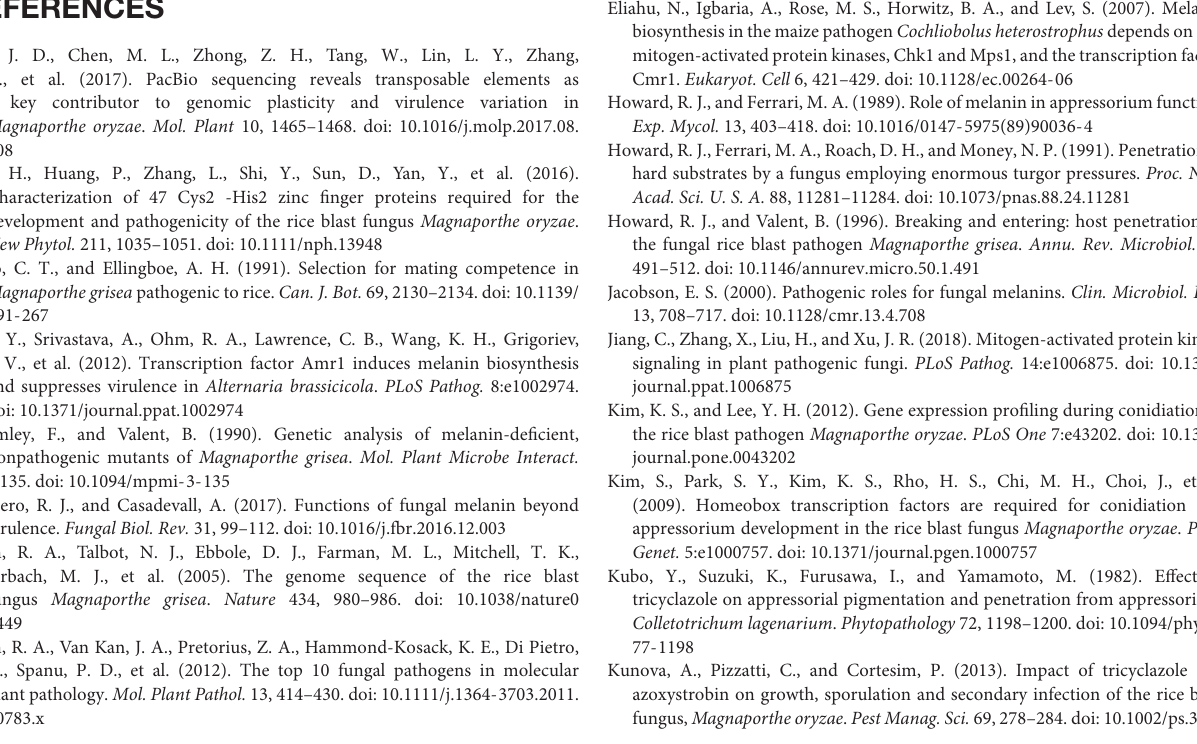
Supplementary Figure 1 | Targeted deletion and complementation of genes in M. oryzae strains. (A) Strategy for targeted gene deletion. Two primer